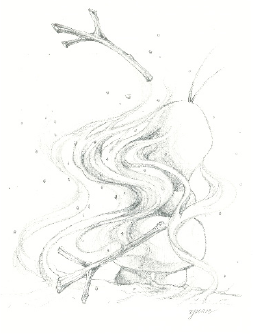
Figure 1. The creation of Olaf.